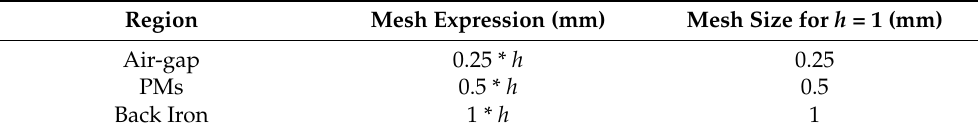
Table 3. Mesh size selection method.